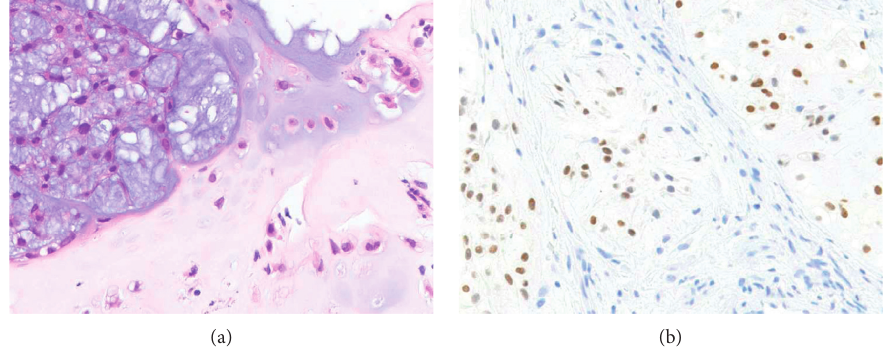
Figure 1: Histopathology of the tumor resected from the skull base of the patient. (a) Hematoxylin and eosin and (b) positive expression of Brachyury in the nucleus of tumor cells.